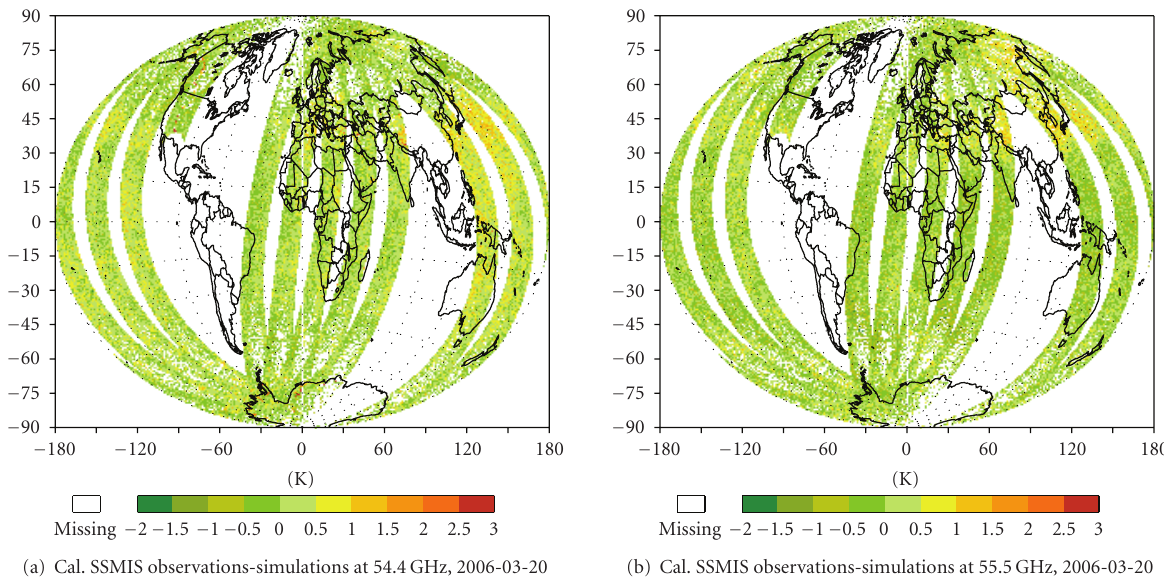
Figure 9: Global distributions of antenna temperature bias between F16 CTDR measurements and radiative transfer simulations where “Cal.” denotes the calibrated antenna temperatures using the newly developed calibration algorithm for (a) 54.4GHz and (b) 55.5 GHz.